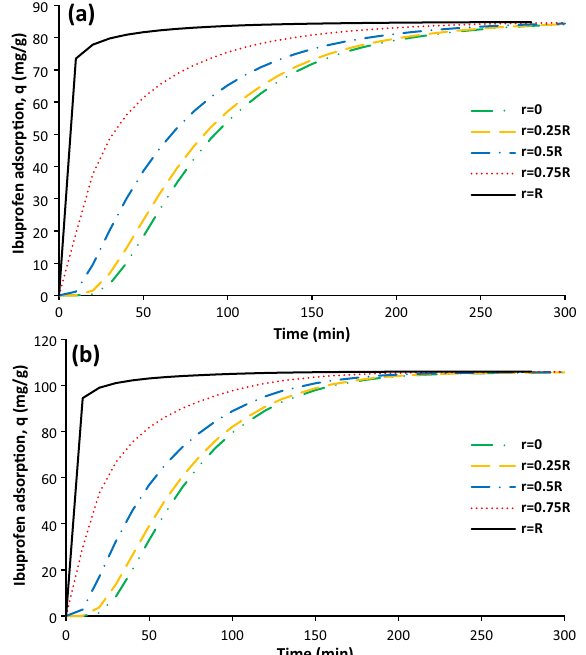
Figure 2. Ibuprofen adsorption as function of time at different position in particle for AC ( a ) and SAC ( b initial ibuprofen concentration = 100 mg/L, T = 298 K, pH = 2, AC porosity = 0.392, SAC porosity = 0.474, adsorbent dosage of 0.5 g/L, and particle radius = 163